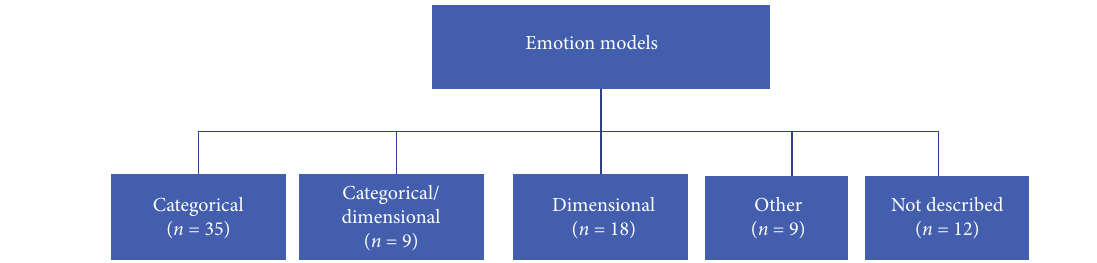
Figure 5: Emotion models identi fi ed in the documents Table 4: Author mentions as a function of the document ’ s emotion approach.